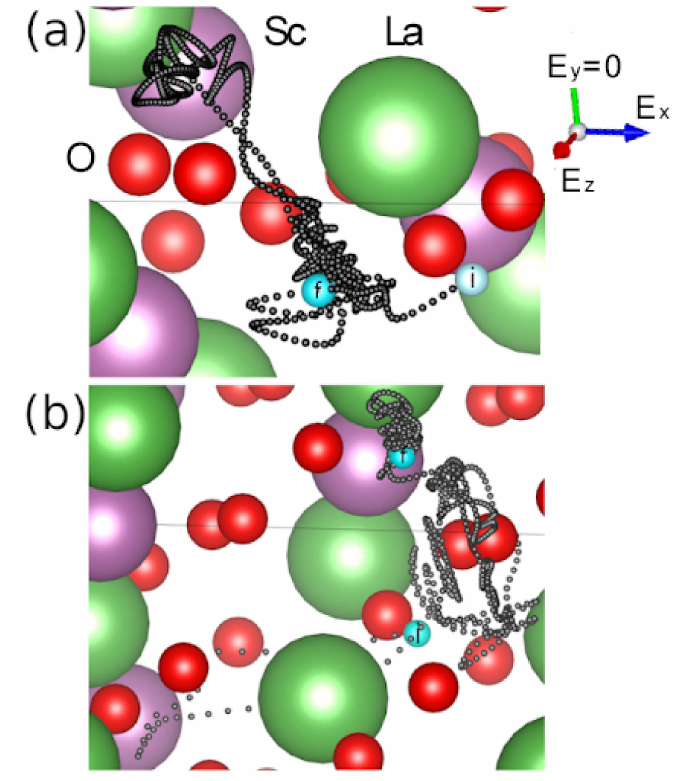
Figure 4. Horizontal projections of the configurations of the LaScO 3 crystal, corresponding to the time instant of 1 ps, ( a ) under the electric field with an intensity of E = 0.7071 × 10 10 V/m and ( b ) without the electric field; the figure also shows the trajectories of the proton for the specified time interval, and the symbols i and f denote the beginning and the end of the trajectory,